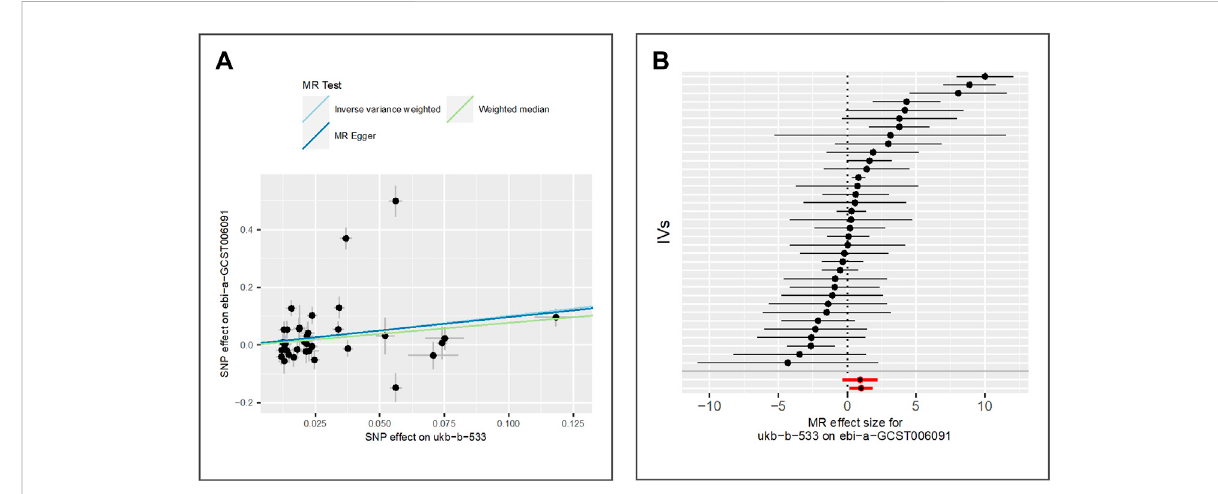
FIGURE 7 Comparison of MR methods and results associated with freckles: (A) scatter plot re fl ects SNP effects on the freckles against SNP effects on the exposure; (B) forest plot represents the causal effect of exposure on the outcome using each SNP singly.